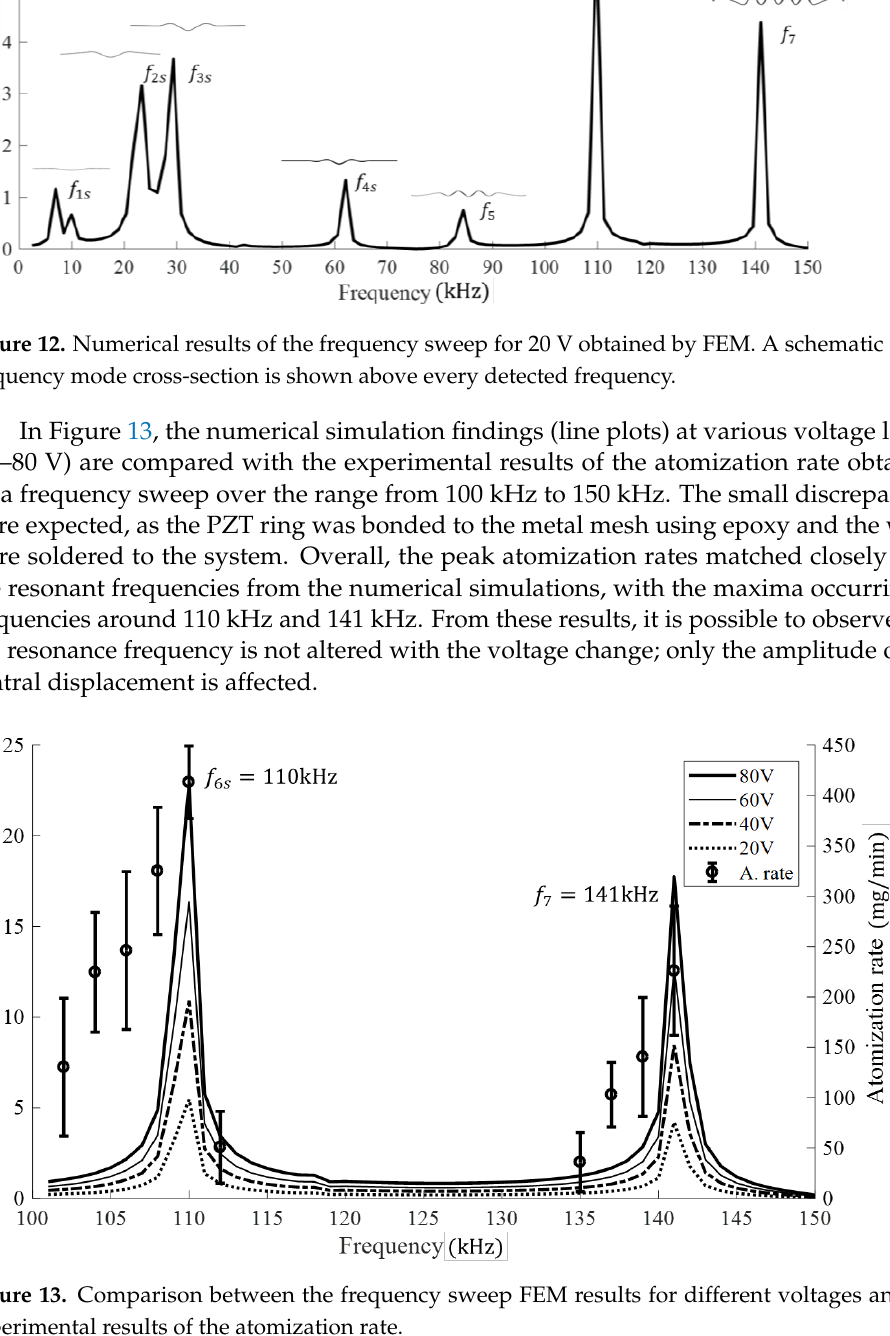
Figure 14. FEM estimation of the maximum micro-aperture variations as a function of the cycling changes in the applied voltage. Additionally, the global liquid volume displaced by the thin plate was calculated based on the FEM results (Figure 15). The distribution of the particle displacement at the surface of the thin plate as given by the FEM was calculated by using the shell method of integration [28]. An illustration of the integration method considering the limits ( 𝑎 𝑛 , 𝑏 𝑛 ) is described in Figure 15. This method allows obtaining volumes generated by rotating an area between any two functions, 𝑓(𝑟) and 𝑔(𝑟) , where 𝑓(𝑟) is the displacement curve and 𝑔(𝑟) is a threshold.